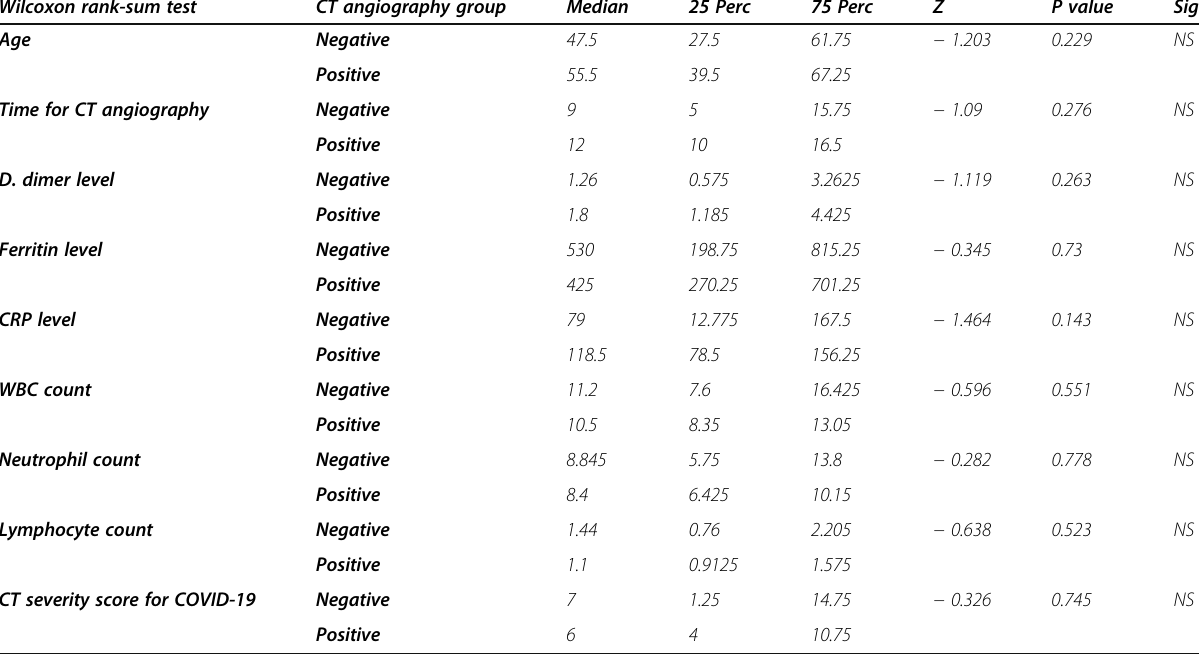
Table 2 Illustrate the median age, the timing of CTPA, laboratory levels, and CT severity score in correlation with the incidence of pulmonary embolism